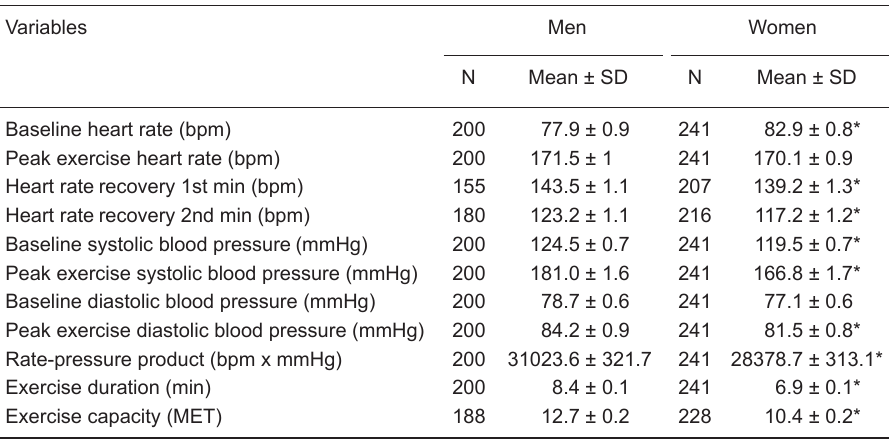
Table 4. Treadmill electrocardiographic exercise stress test characteristics of the men and women of the study sample.